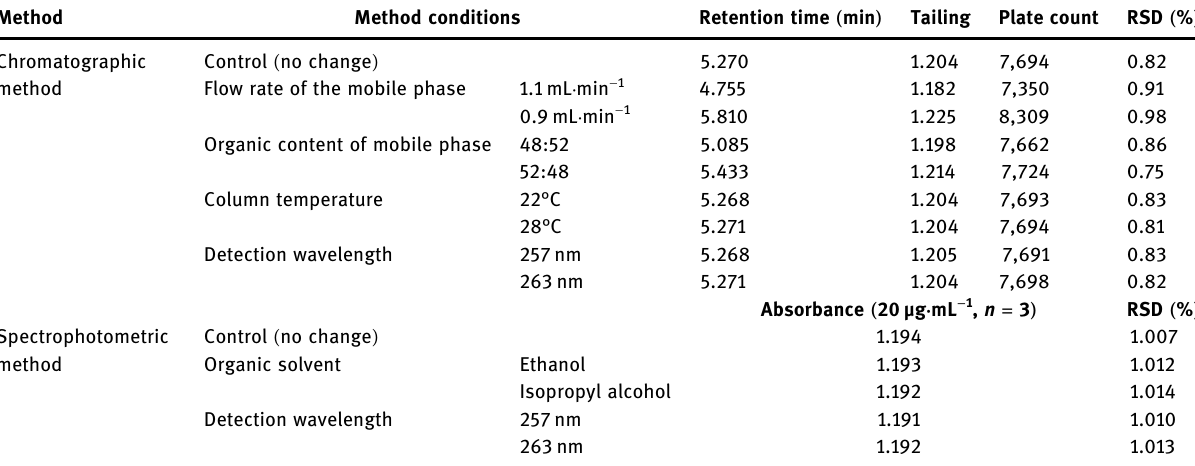
Table 5: The results of the robustness study